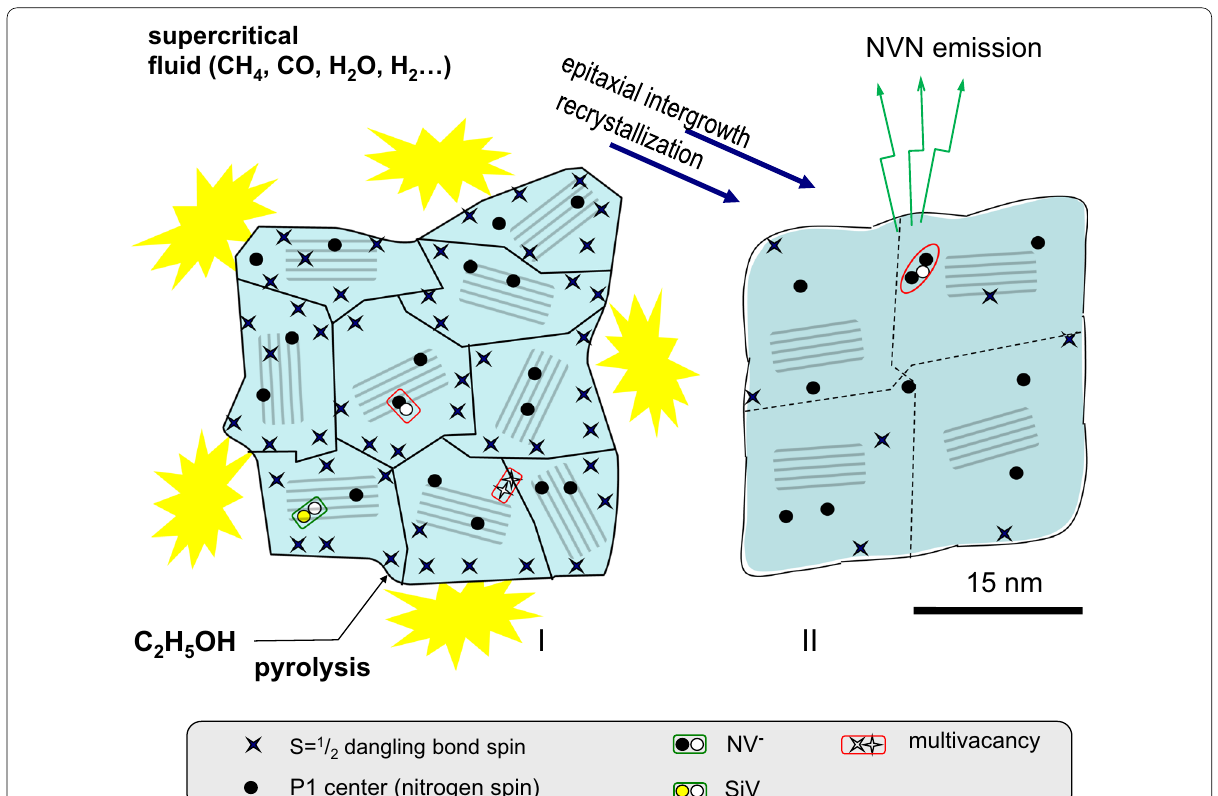
Fig. 1 Schematic illustration of the sintering of polycrystalline diamond particles at high-pressure and high-temperature conditions to produce submicron diamond nanocrystals with sizes of about 30 nm. Various defects and colour centres are observed both in polycrystals (I) and in nanocrystals after the HPHT sintering